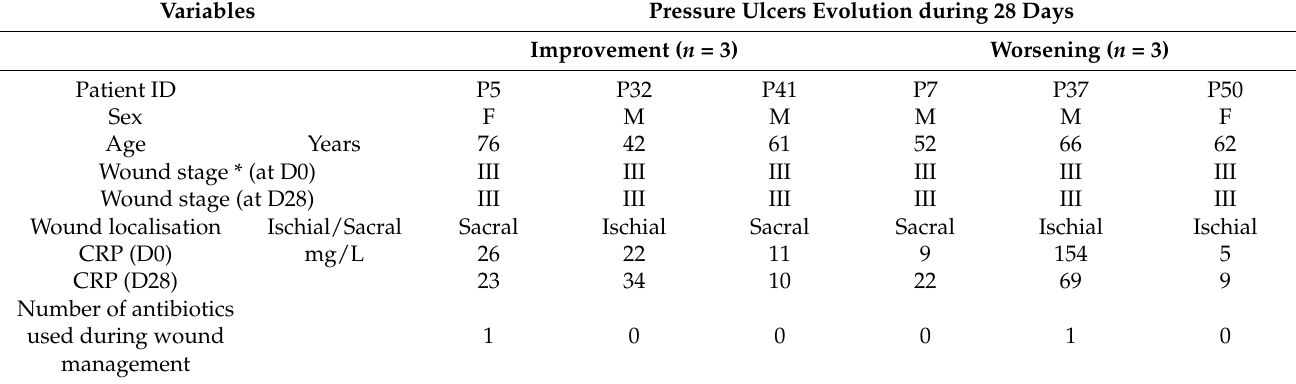
Table 1. Clinical characteristics of SCI patients with pressure ulcers infected or colonised by S. aureus after 28 days and according to wound evolution (improvement vs. worsening evolution).